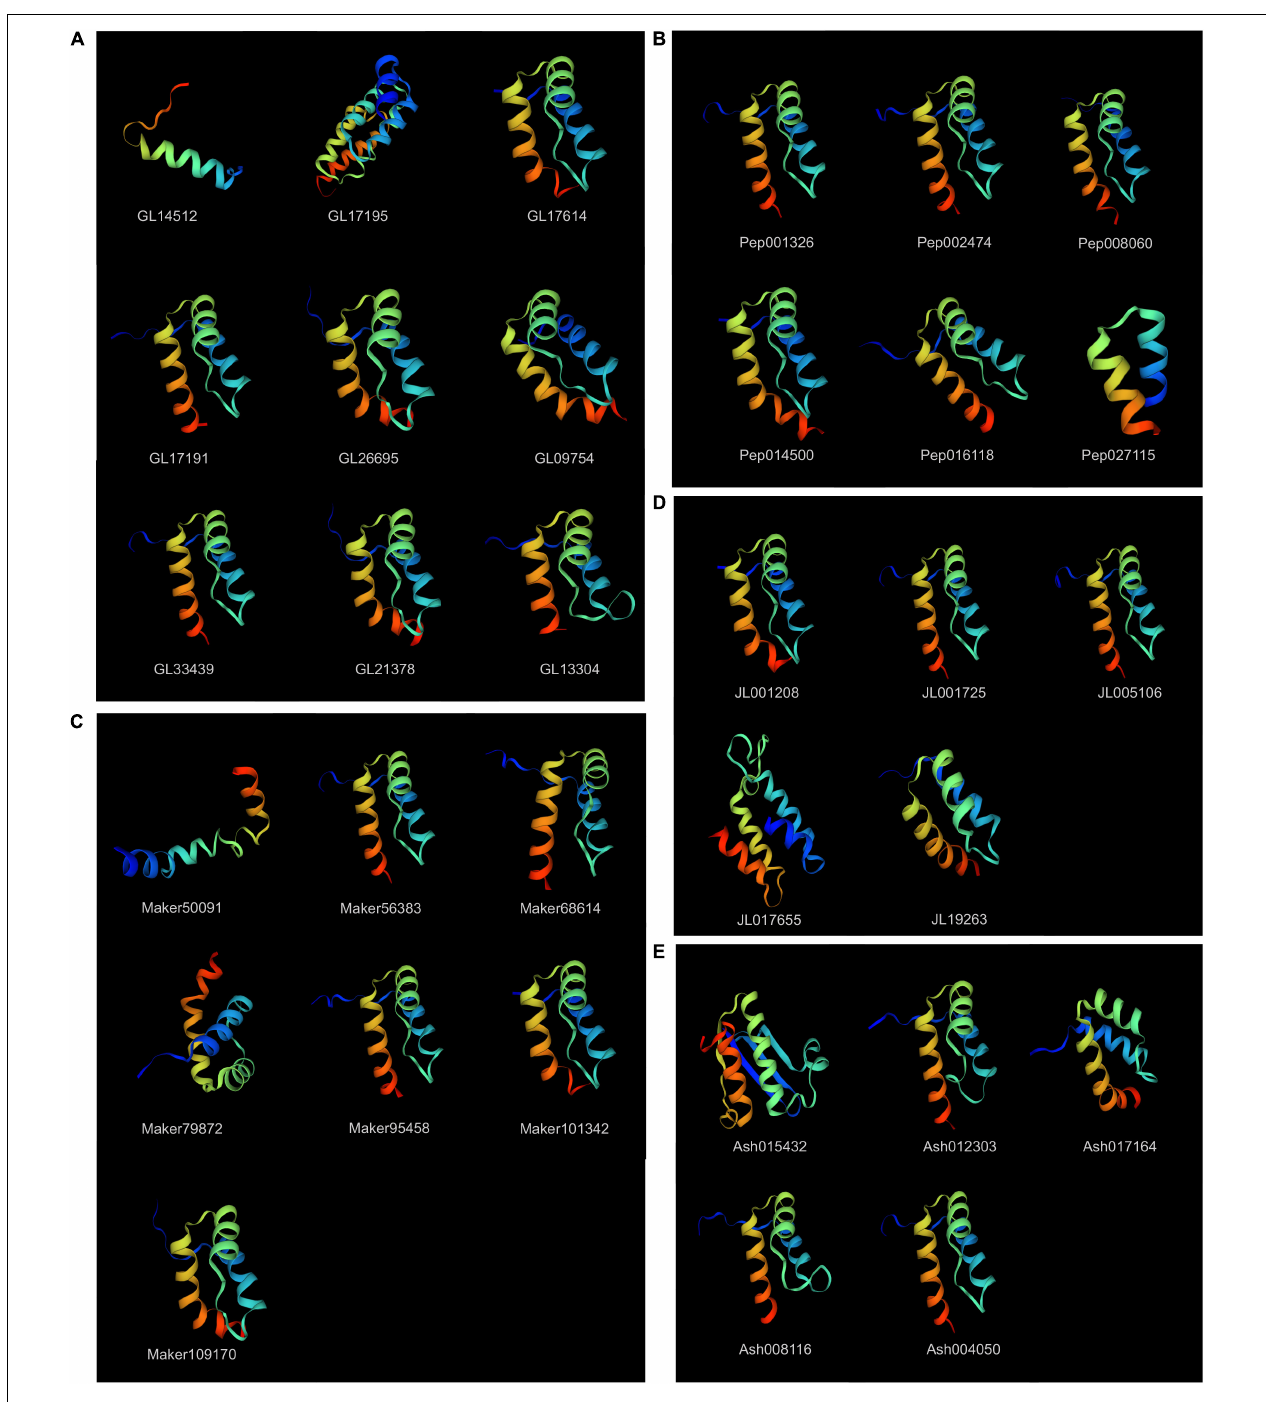
FIGURE 4 | Protein tertiary structure of KNOX genes. (A) C. goeringii . (B) P. equestris. (C) D. chrysotoxum. (D) C. ensifolium . (E) A. shenzhenica. The tertiary structures were colored by rainbow order, representing N to C terminus.